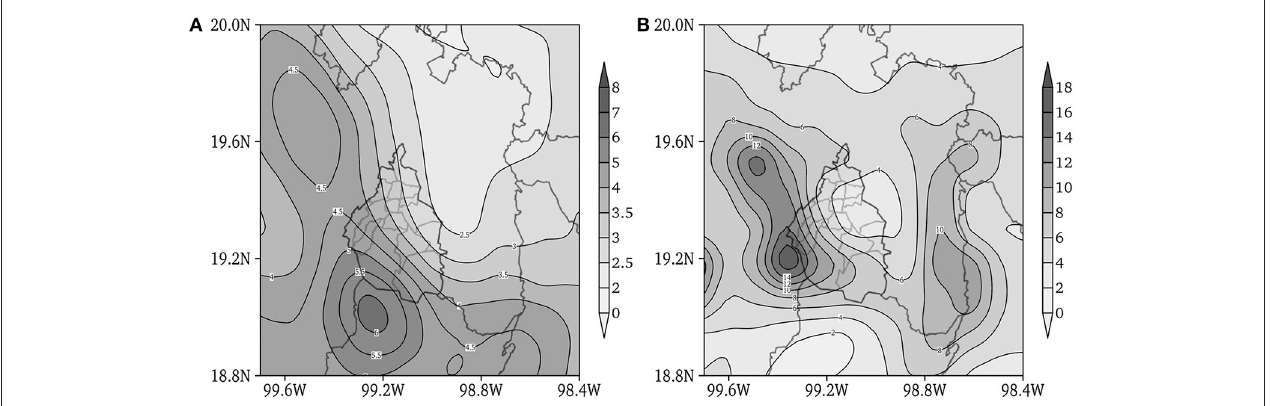
FIGURE 15 | EOF analysis of the precipitation field for July 2014: (A) EOF constructed from surface observations; (B) EOF from the predicted precipitation